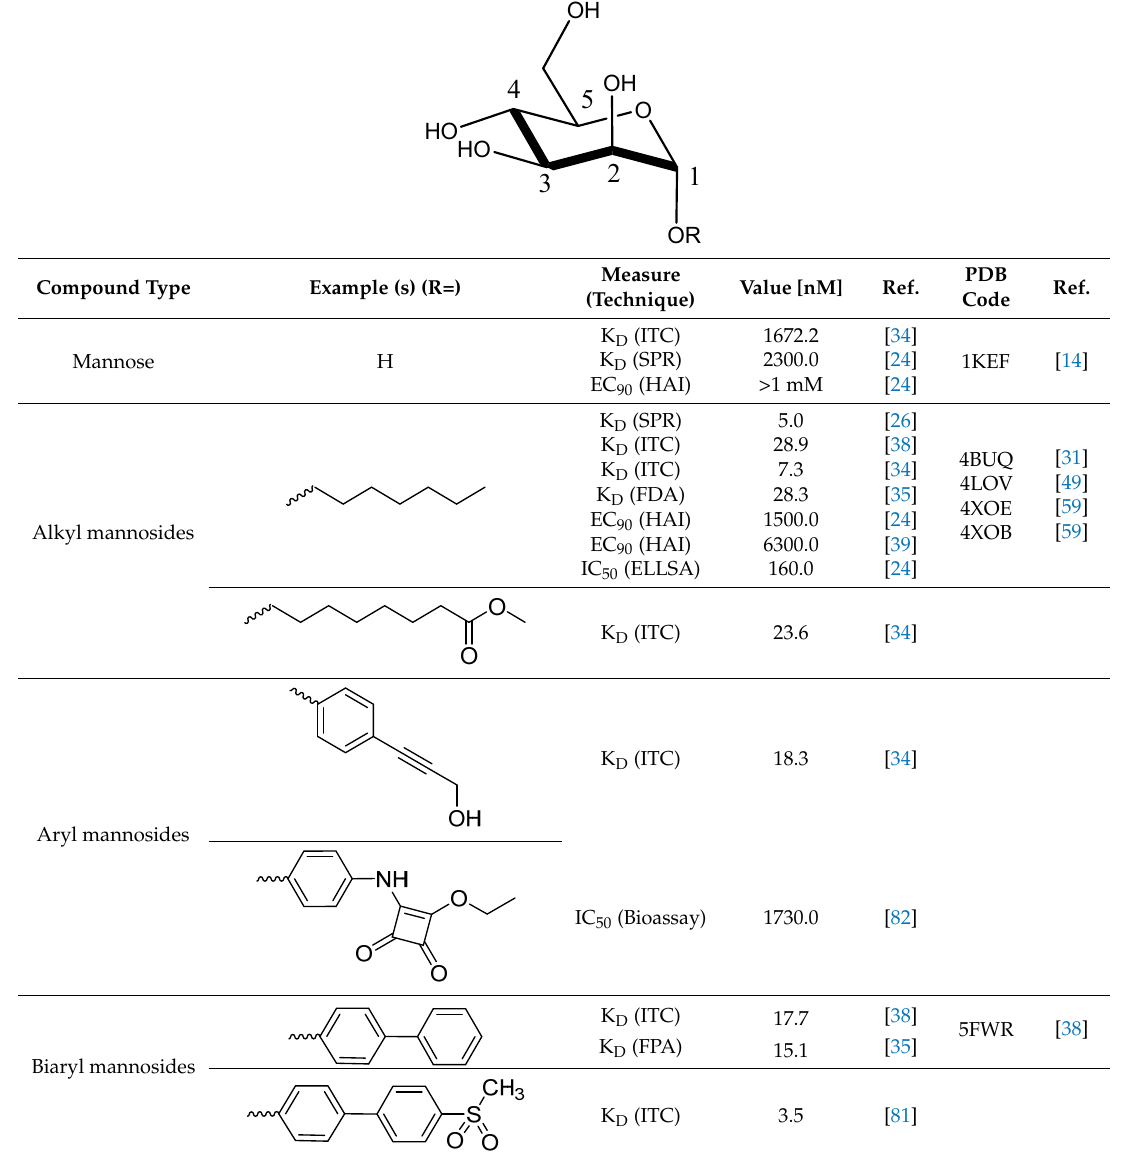
Table 2. Classification of FimH mannosidic inhibitors. For each compound type one or more examples with their affinities are listed. PDB codes for wild-type structures of FimH in complex with the corresponding inhibitors are given. The following abbreviations are used: FDA for fluorescence polarization assay; ELLSA for Enzyme-linked lectinosorbent assay; HAI for hemagglutination inhibition.